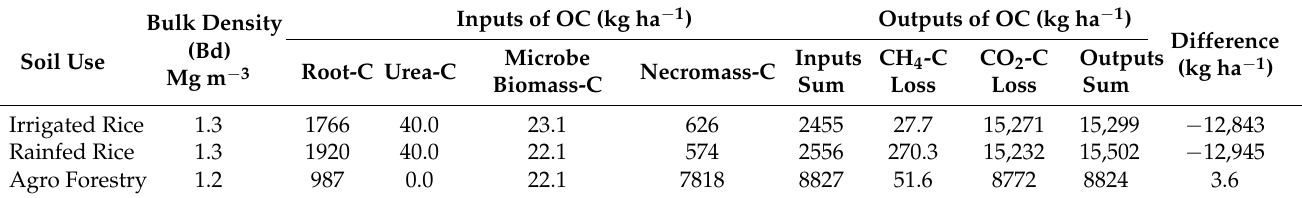
Table 5. Organic carbon (OC) budget of surface soil in the studied soil use